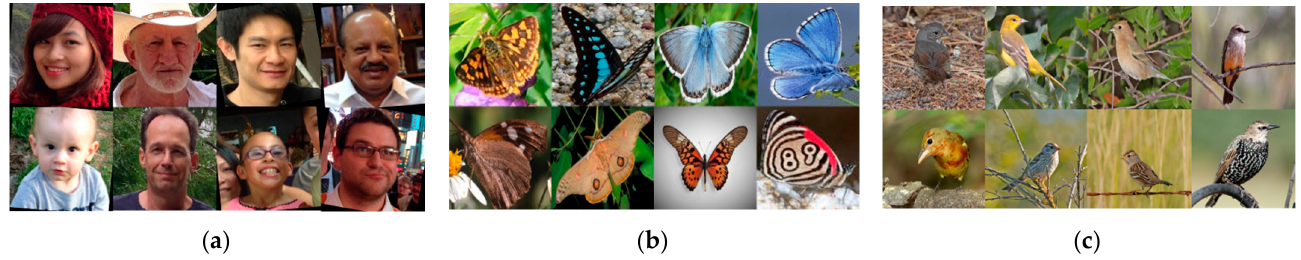
Figure 7. Examples from three datasets. ( a ) The Audience dataset; ( b ) Butterfly & Moths dataset; ( c ) NA Birds dataset.